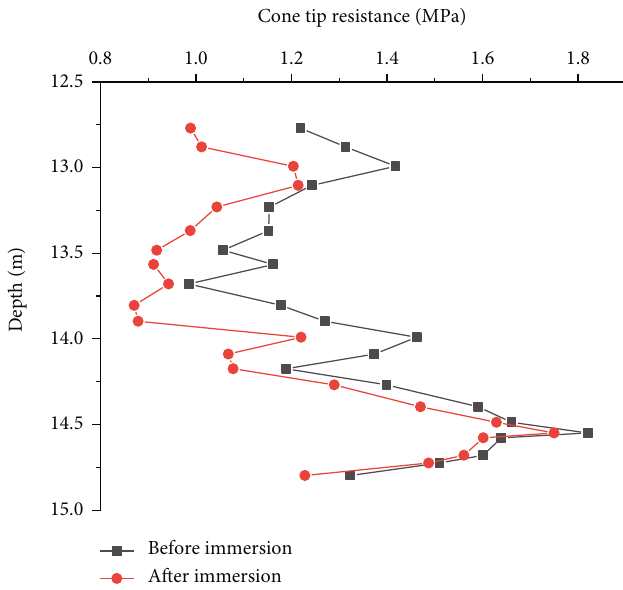
− h curve before and after immersion at the end of pipe gallery foundation. Figure 7: Static cone penetration q c Table 4: Static cone penetration data before and after immersion and inverse calculation of bearing capacity (standard algorithm). Drilling number